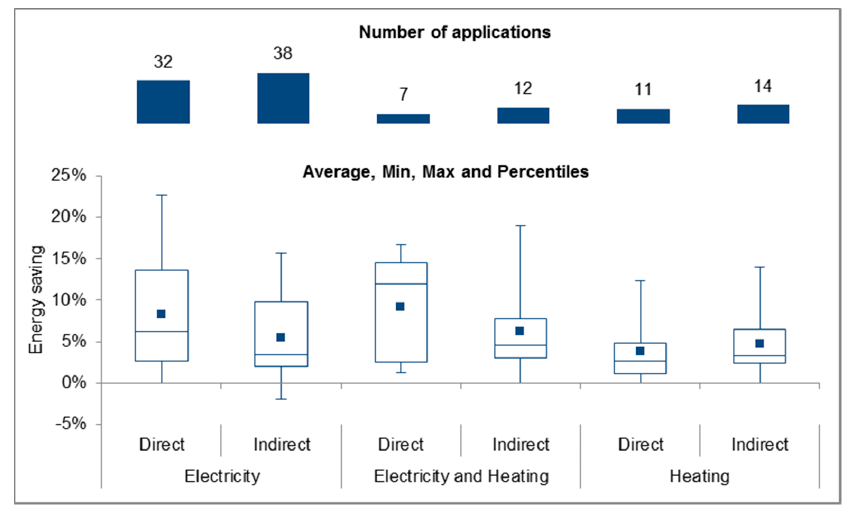
Figure 5. Number of studies and statistical analysis of energy savings, per type of end-use, and feedback (based on 114 out of 114 feedback applications).